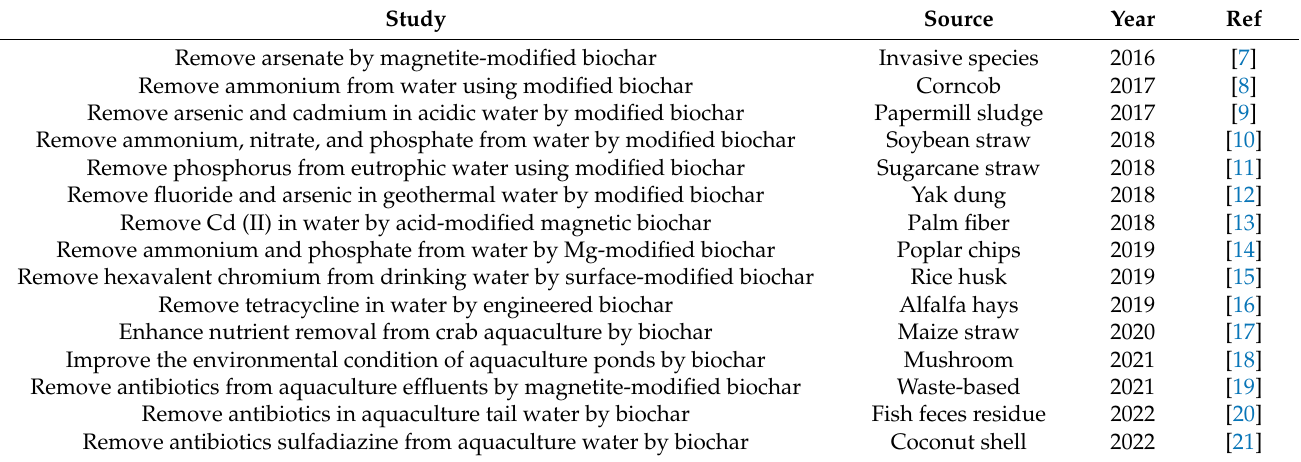
Table 1. A summary of recent conducted studies, using engineered biomaterials for water